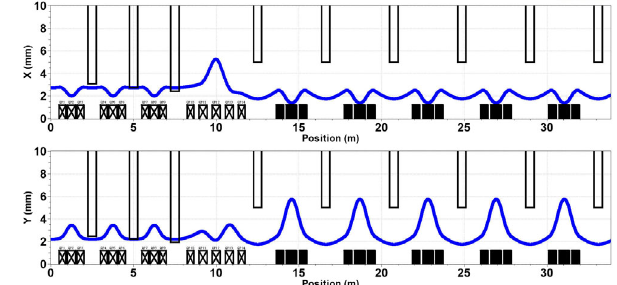
FIG. 10. Emittance of the collimation section and acceptance of the VDS section for 1.5 GeV beam. The dark area is the acceptance of VDS section. The white hexagonal area is the maximum beam emittance after collimation. Particles in blue and yellow colors are collimated beam emittance.